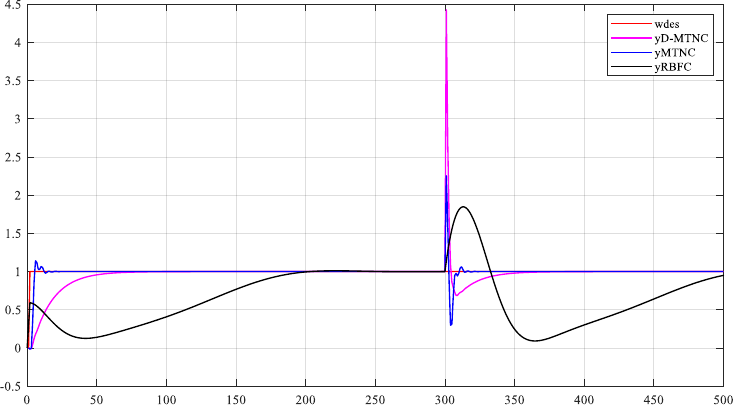
Figure 6. The tracking trajectory with noise.